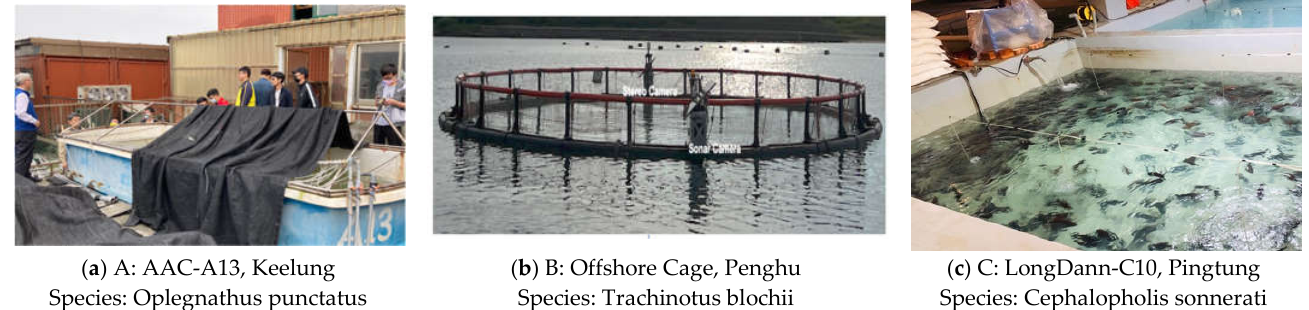
Figure 6. Experimental environments utilized for training various deep learning models for fish length estimation, fish count estimation, and fish type annotation.